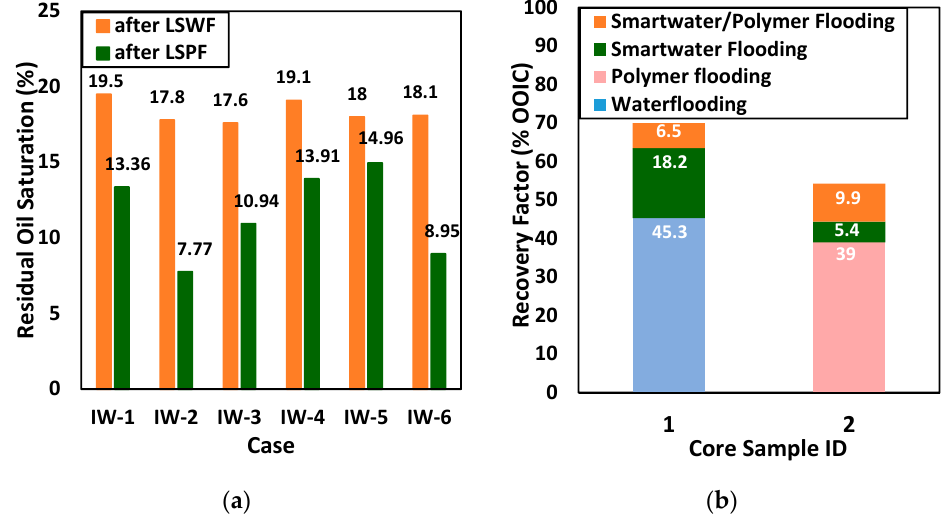
Figure 5. ( a ) Reduction in S or after LSPF [135] ( b ) additional recovery using EWPF in carbonate reservoir cores [139].